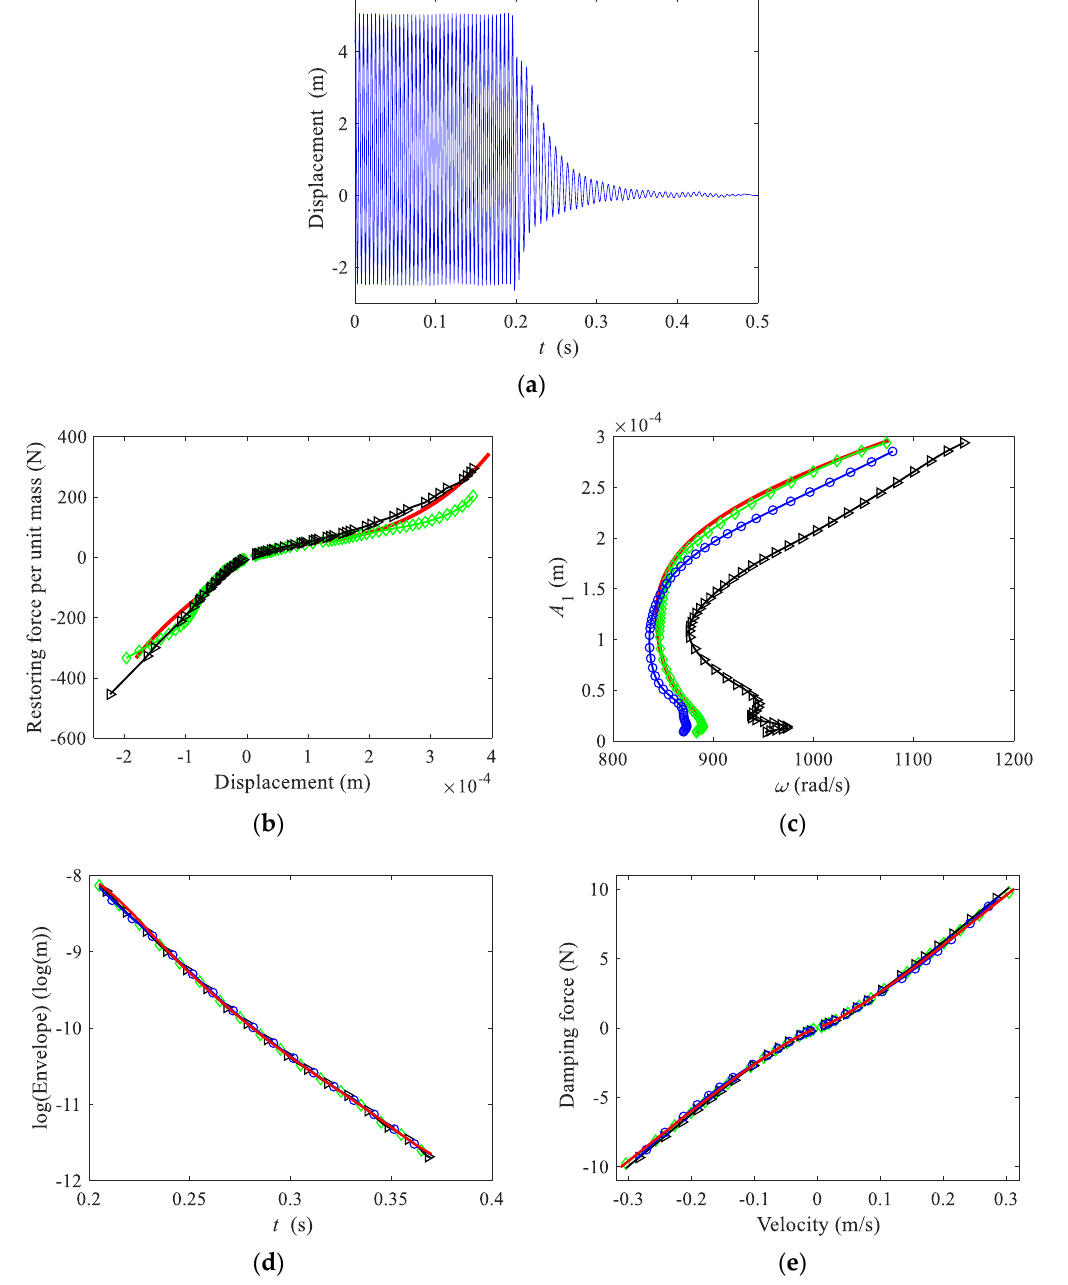
Figure 7. Measured ( a ) time domain response, ( b ) restoring force curve, ( c ) backbone curve, ( d ) logarithmic form of the envelope, ( e ) damping force curve. Thin solid line, time domain response; thick solid lines, Hilbert transform; lines with diamonds, zero-crossing; lines with triangles, direct quadrature; lines with circles, wavelet transform.